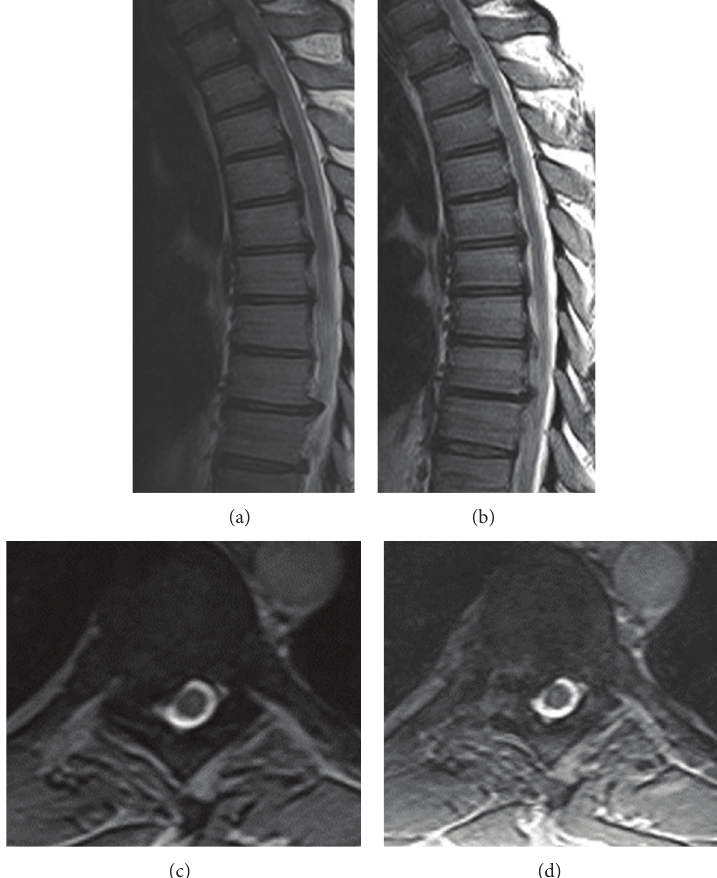
Figure 6: Preoperative MRI images of a T8-9 disc herniation compressing the spinal cord, which caused the patient to have mid back pain radiating to the shoulder blade ((a) and (b)). Postoperative MRI images showing removal of the extruded disc material ((c) and